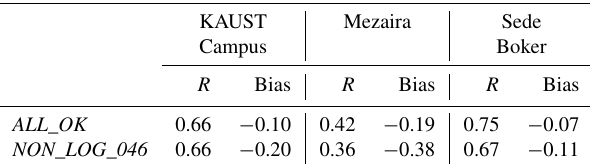
Table 6. Pearson correlation coefficient R and mean bias calculated for AOD time series from two runs with respect to AERONET AOD